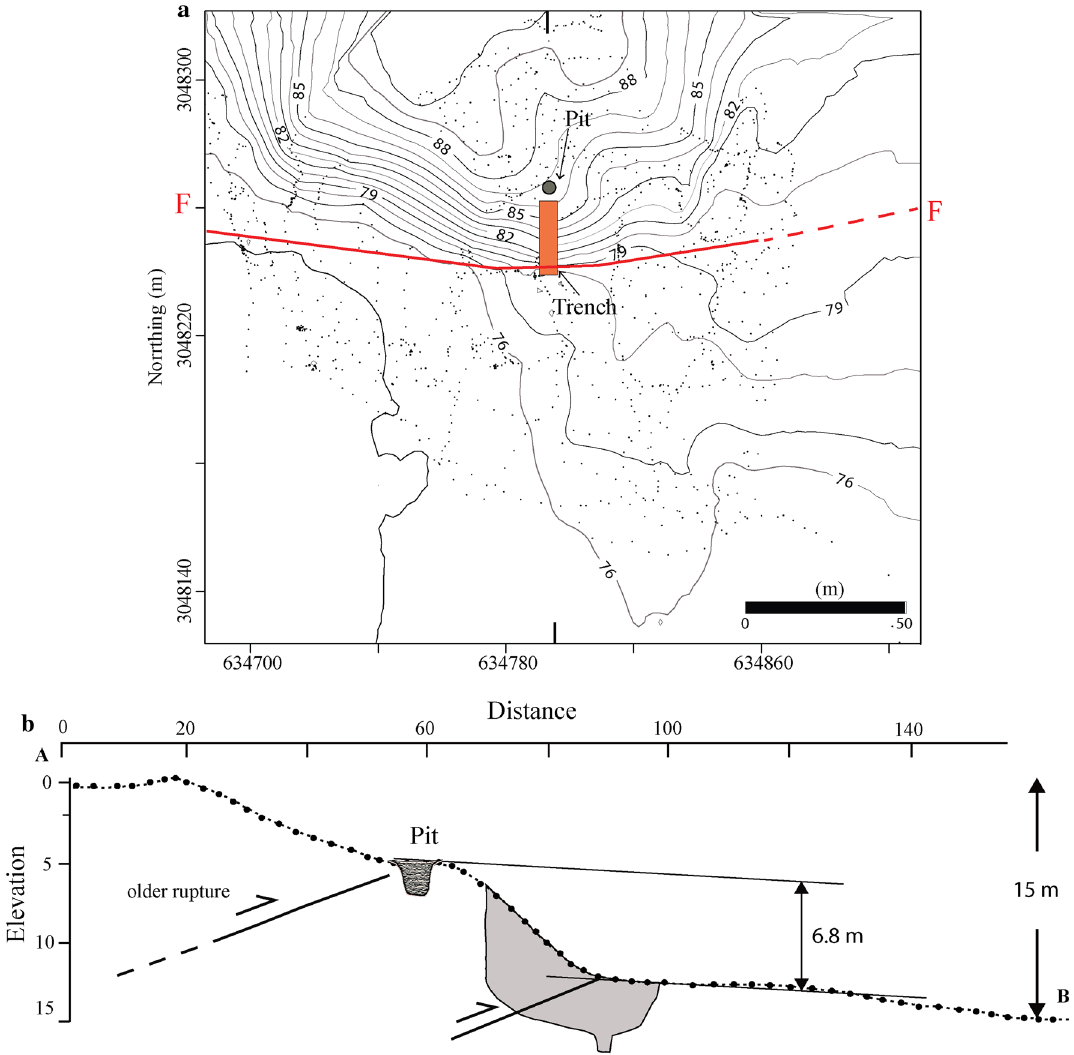
Figure 3. Topographic map of Himebasti trench site, contours on the map are at 1 m interval based on a survey using Real-Time Kinematic Global Positioning System (RTK-GPS) in UTM 46N coordinates. An orange rectangle denotes the location of a N-S oriented trench (Top). RTK-GPS N-S (along AB) topographic profile across the fault scarp and projection of the Himebasti trench is shown in the bottom figure. The excavated pit has been projected over the ~ 6.8 m high fault scarp. Location of the pit is shown in Fig. 2, and field photograph is shown in Supplementary Fig. S3. Contour map and profile were prepared in Leica Geo Office v7.0 programme and artwork in Adobe Illustrator CS5